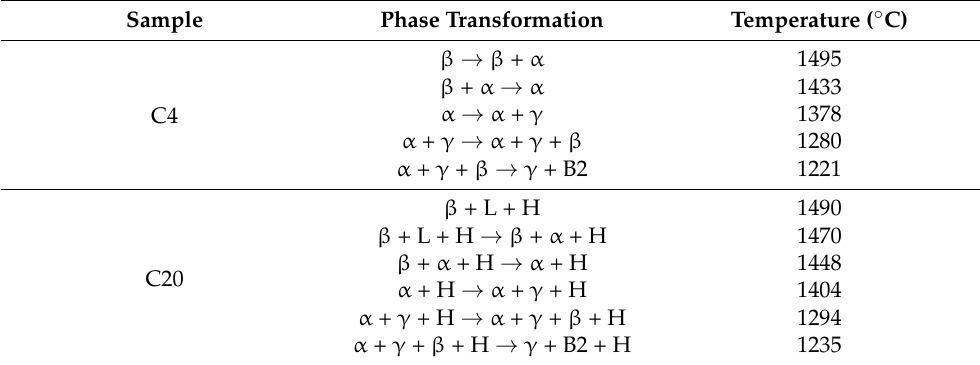
Table 3. Overview of the phase transformation sequences and corresponding temperatures deter- mined from DTA cooling